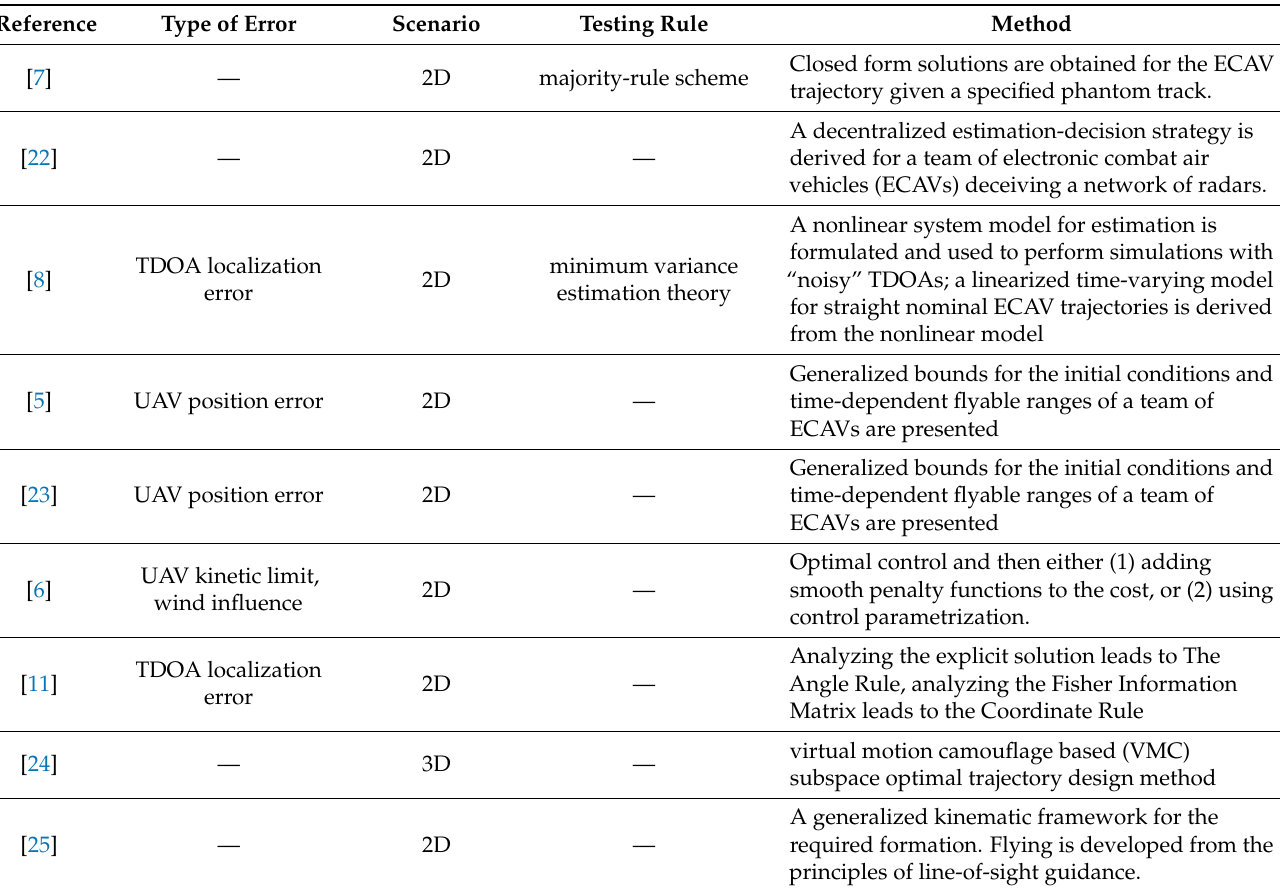
Table 1. Related work by US